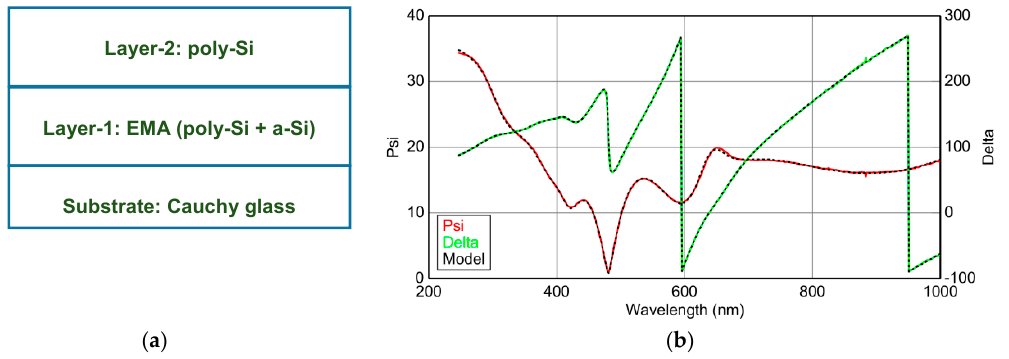
Figure 2. Spectroscopic ellipsometer (SE) results for furnace annealed Si film at 650 °C: Optical model used for fitting SE data ( a ) and experimental (solid) and fitted (dotted) plot for psi ( Ψ ) and delta ( Δ ) vs. wavelength ( b ).